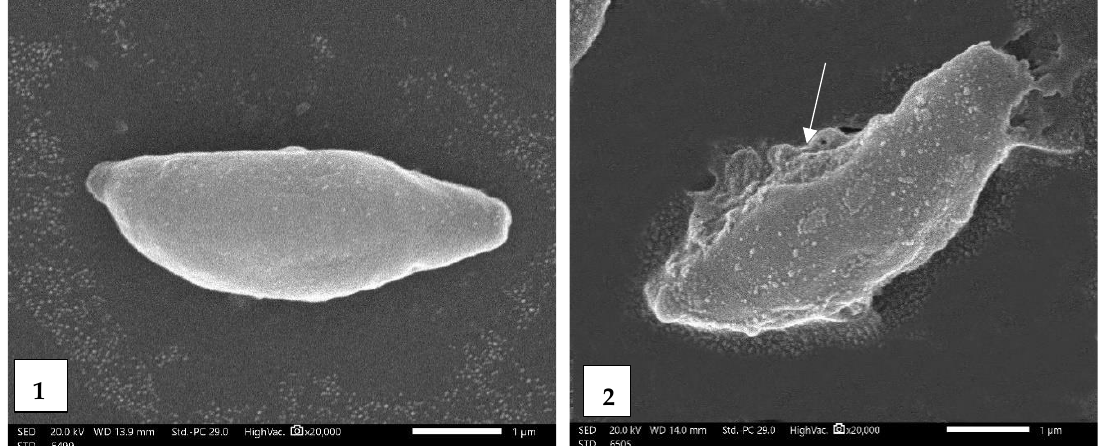
Figure 6. SEM of Toxoplasma gondii tachyzoite in infected untreated control group showing completely regular smooth surface ( 1 ) ( × 20,000) and ( 2 ) A SEM of Toxoplasma gondii tachyzoite in infected group showing completely irregular surface, multiple ridges, irregular papules, and dimples (arrow) (×20,000).